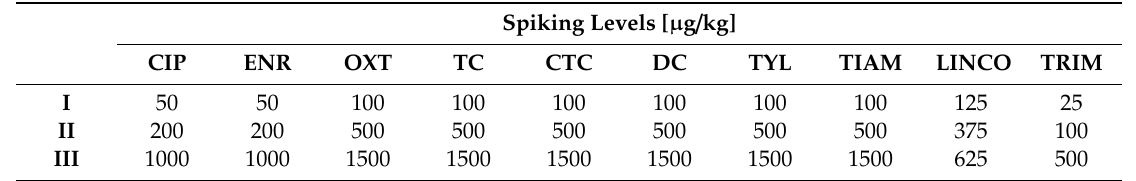
Table 6. Validation spiking